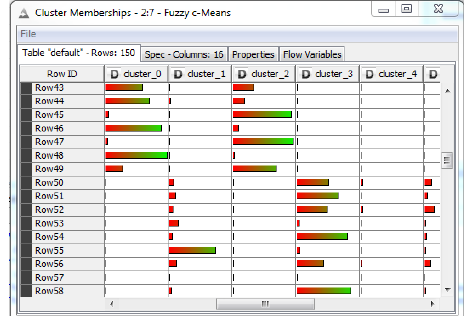
Fig. 8. An example of fuzzy intervals in KNIME. The un- derlying meta data is at the top, while the data as it is shown in a table can be seen underneath.